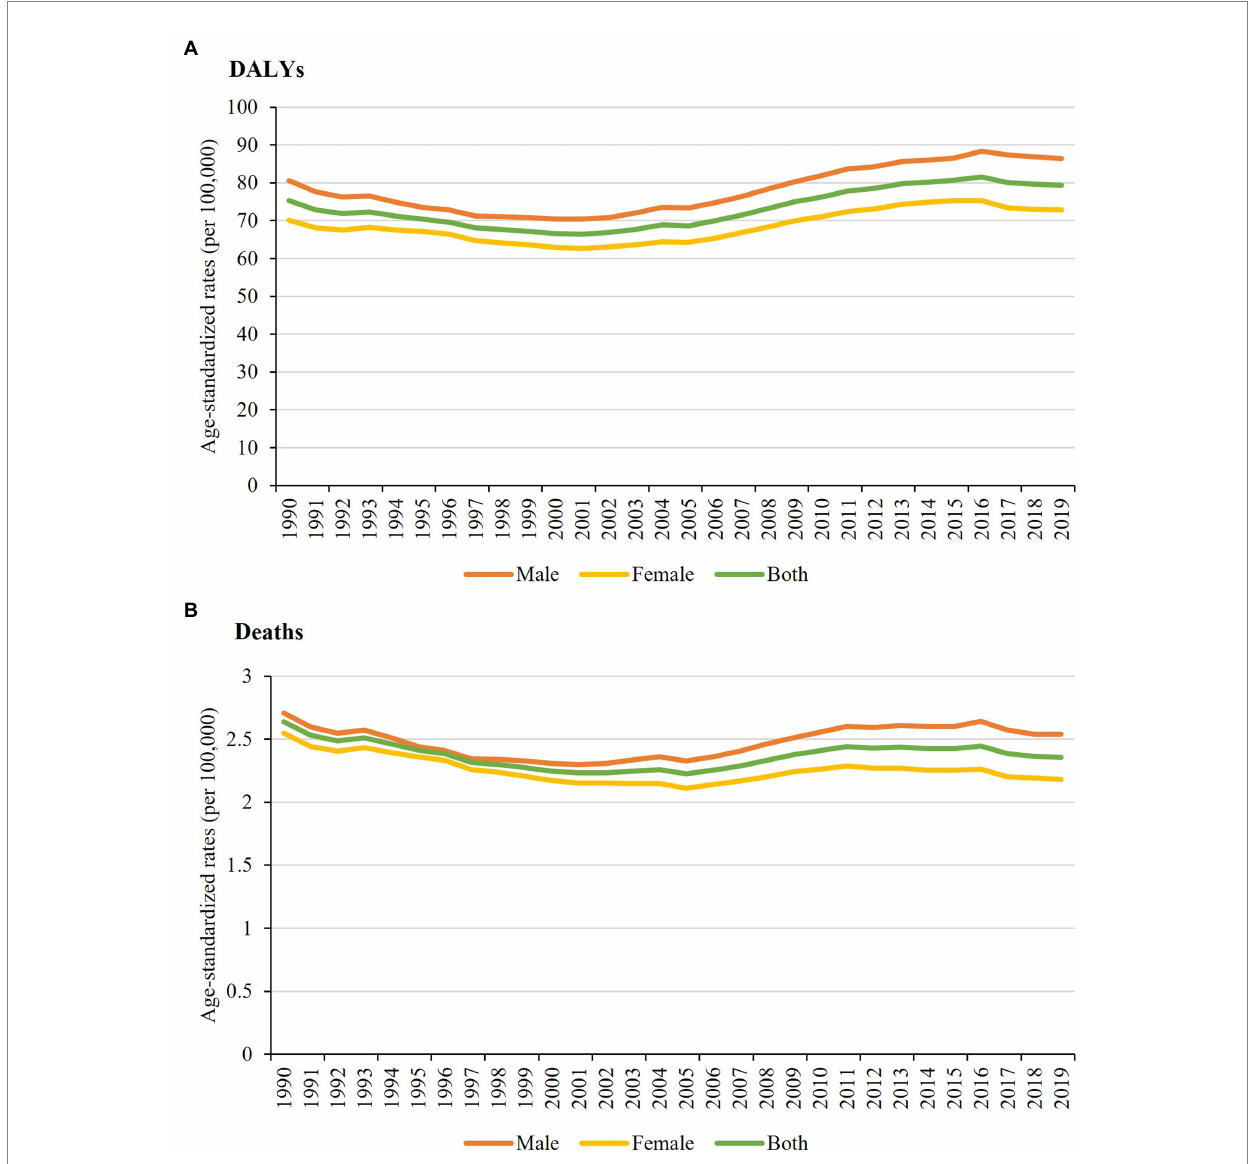
FIGURE 1 Age-standardized disability-adjusted life years (A) and deaths (B) rates per 100,000 inhabitants for chronic noncommunicable diseases attributable to a diet rich in processed meat for both sexes and stratified by sex in Brazil between 1990 and